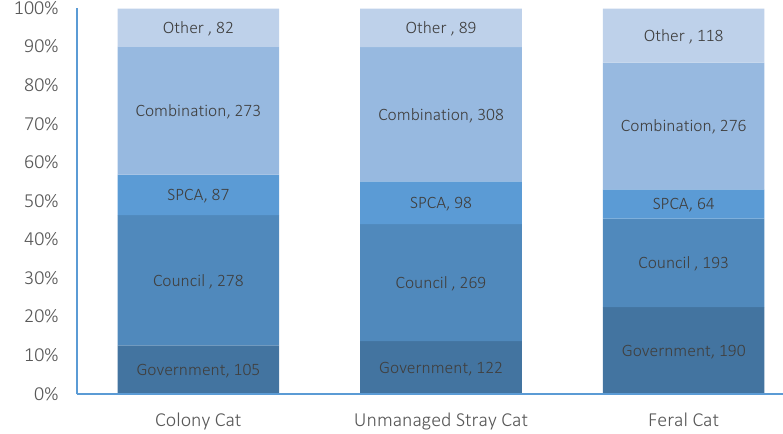
Figure 5. Participant opinion on the action that should be taken to control each subgroup of un-owned cats in New Zealand.